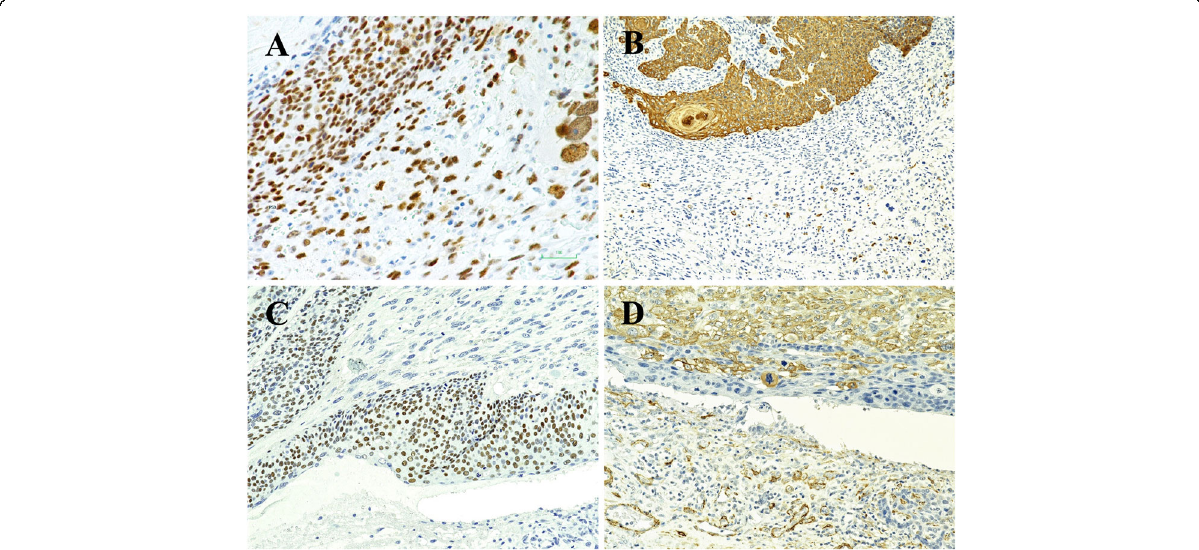
Fig. 2 Immunohistochemistry profile. Immunohistochemistry demonstrated a : positive P53 staining in the nucleus of both carcinoma and sarcoma components (× 20), b : positive AE1/AE3 in the carcinomatous component and scattered-positive in the sarcomatous component (× 4), c : positive P63 nuclear staining in the carcinomatous component (× 20), and d : positive SMA staining in the pleomorphic spindle cells and negative staining in the carcinomatous component (×